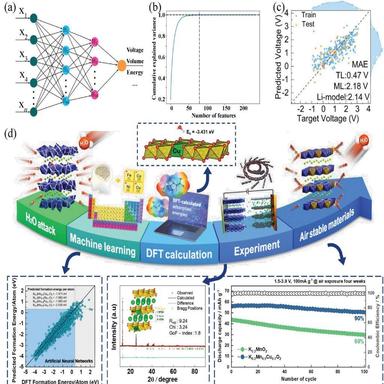
(a) Architecture of the DNN. (b) PCA for the feature vectors. Reproduced with permission from Ref. . Copyright 2019, American Chemical Society. (c) Plots of predicted voltage and target voltage for the Zn-ion batteries. Reproduced with permission from Ref. . Copyright 2022, Springer Nature. (d) Schematic representation of ML-DFT-experimentally driven new cathode KxMnO2 discovery and design. Reproduced with permission from Ref. . Copyright 2021, Royal Society of Chemist